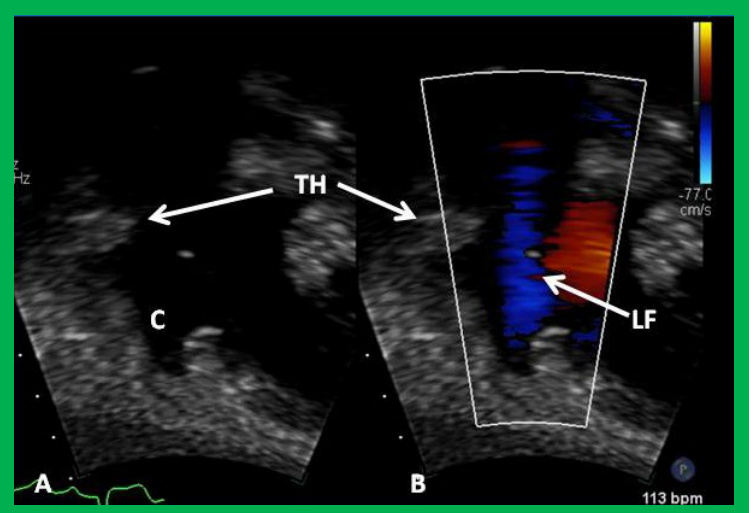
Figure 59. Selected video frames demonstrating wide open conduit (C) by 2D ( A ) and color flow imaging ( B ) despite the thrombus (TH). Laminar flow (LF) and pulsed and continuous wave Doppler interrogation (not shown) do not indicate obstruction.